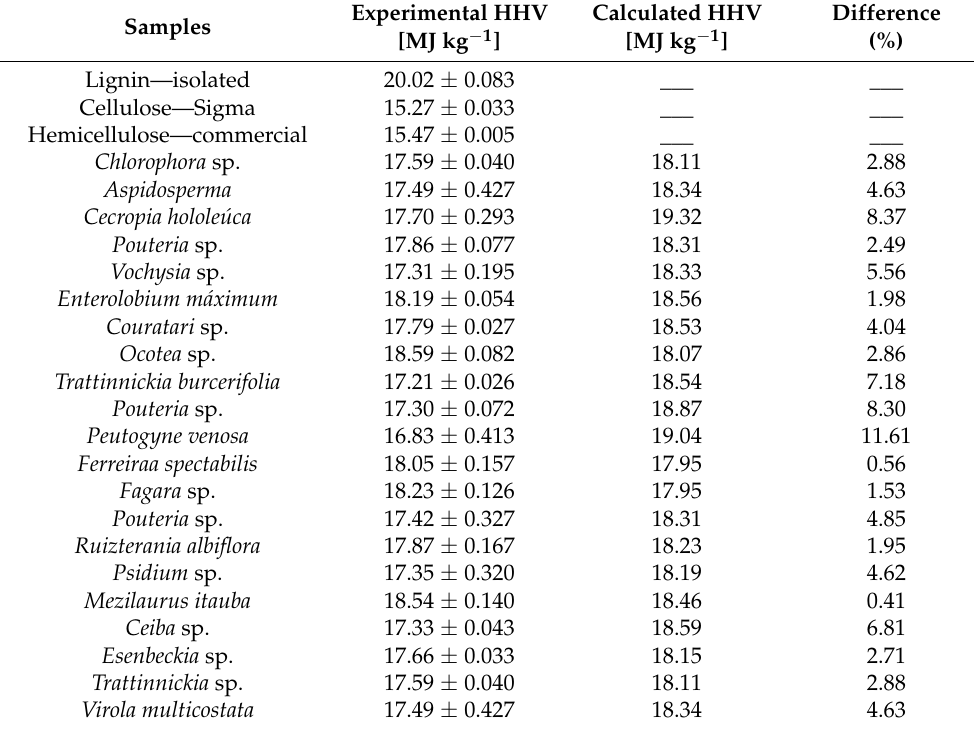
Table 3. Comparison between experimental HHVs and calculated results using Equation (1), as well as HHVs from commercial isolated samples from lignocellulosic